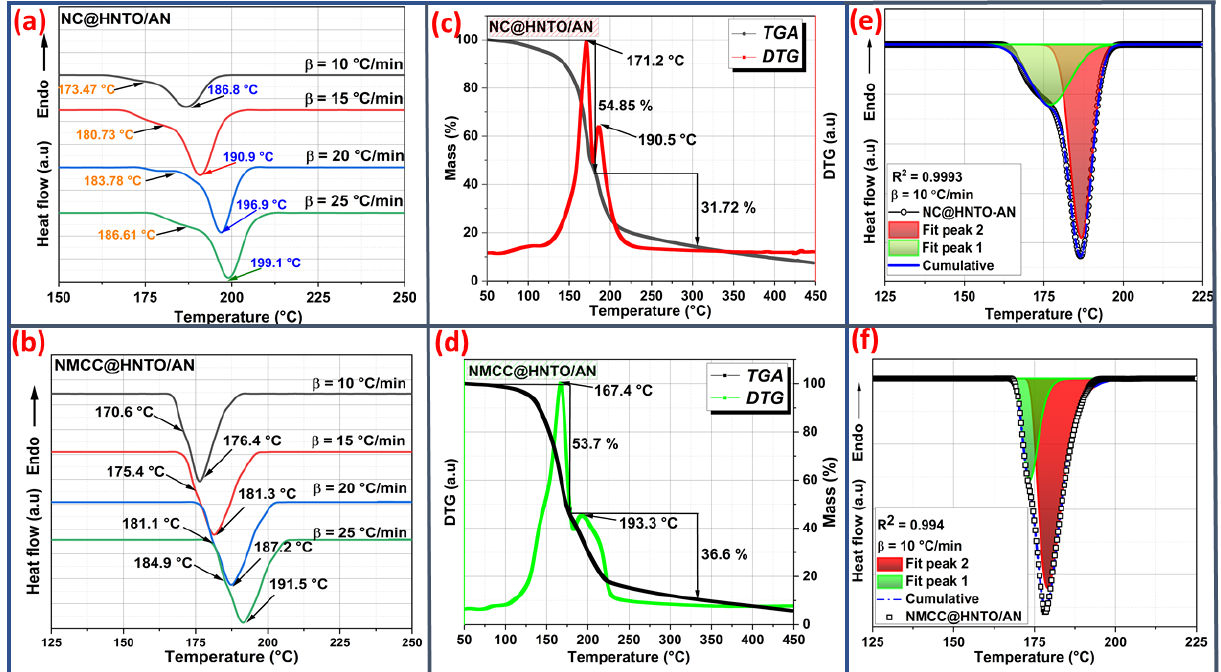
Figure 4. ( a , b ) DSC thermograms at various heating rates of the energetic composites; ( c , d ) TGA/DTG curves of NC@HNTO/AN and NMCC@HNTO/AN at β = 10 °C/min; and ( e , f ) deconvo- curves of NC@HNTO/AN and NMCC@HNTO/AN at β = 10 ◦ C/min; and ( e , f ) deconvolution lution illustrations of the DSC curves at β = 10 °C/min. illustrations of the DSC curves at β = 10 ◦